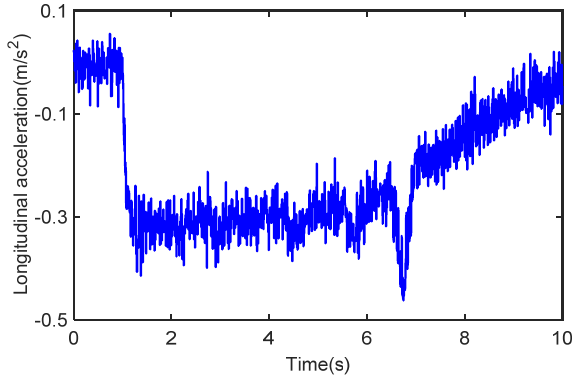
Figure 10. The acceleration in the case of deceleration.